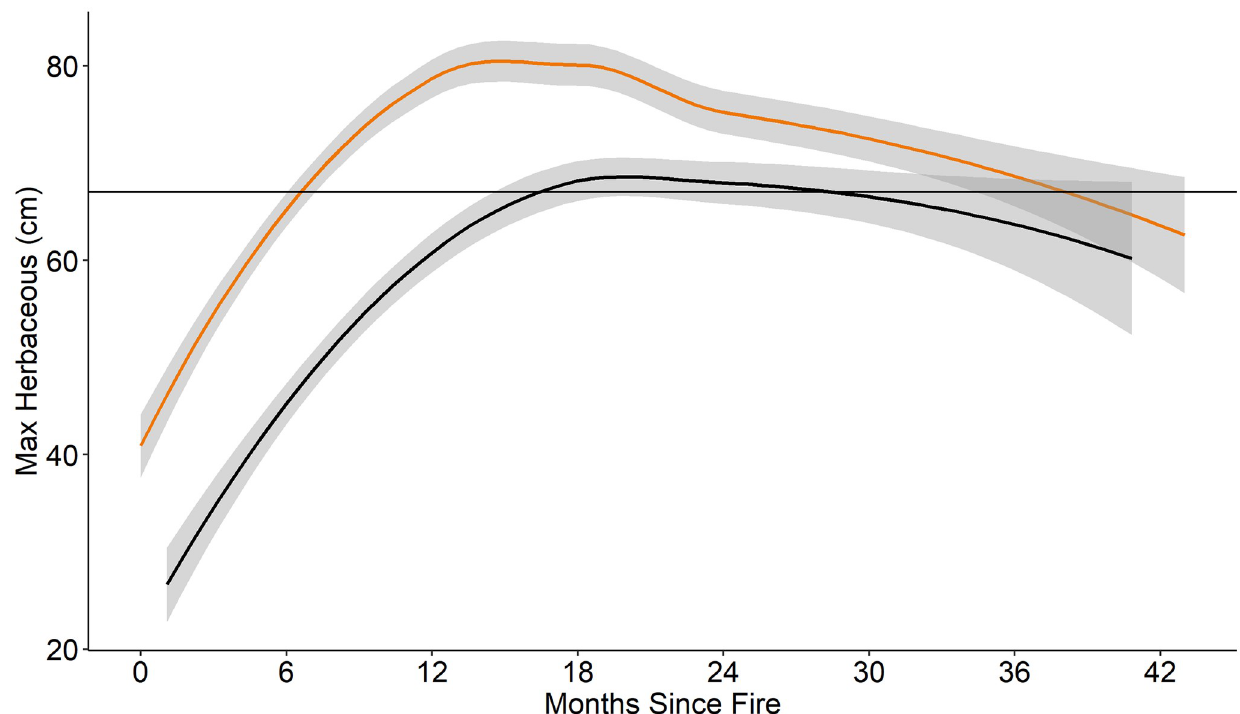
Fig 5. Maximum herbaceous vegetation. Maximum height (cm) of herbaceous vegetation in fire-only (orange) and pyric herbivory (black) treatments at all sites from 2014 to 2016. Shaded area indicates 95% confidence interval. Horizontal line represents maximum mean herbaceous vegetation height (67 cm) reported for prairie-chicken nest selection, as found in primary literature. � Regression lines and confidence intervals generated using “loess” locally- weighted smoothing function.